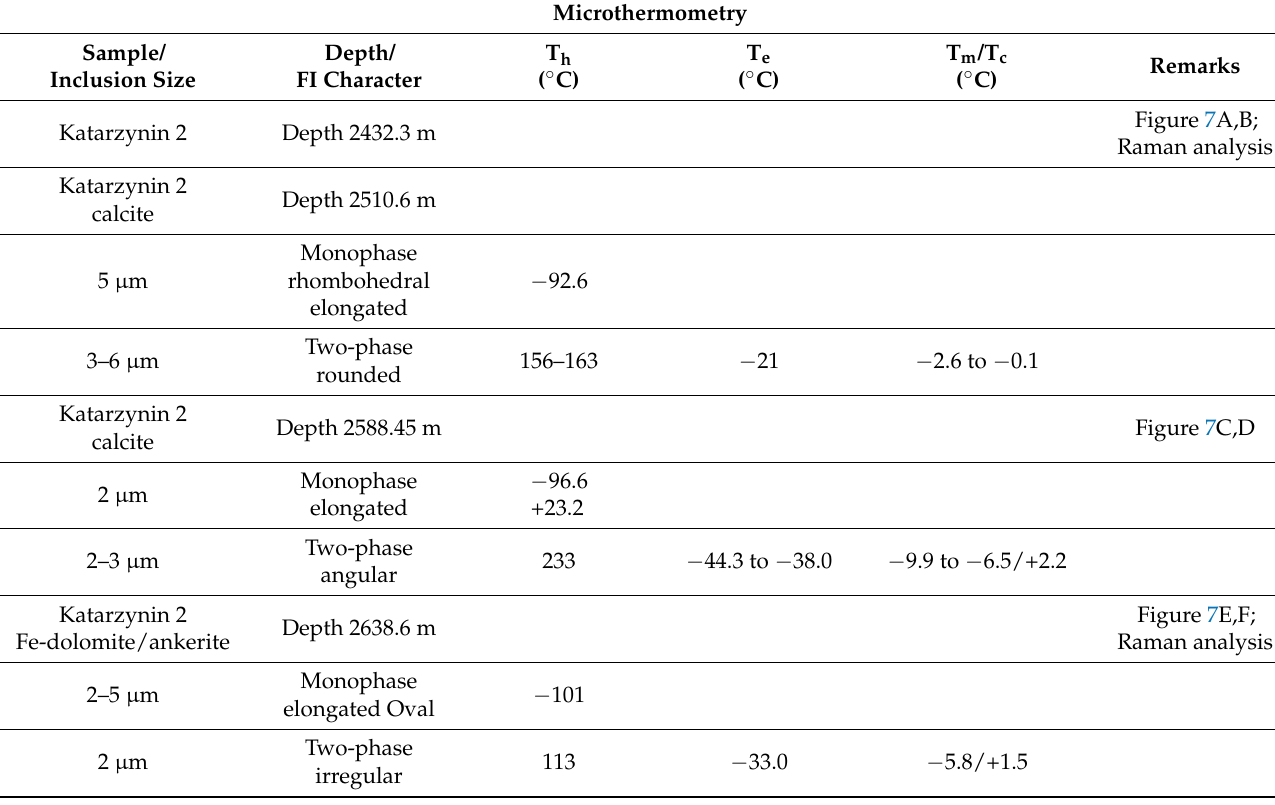
Table 5. Characteristics of fluid inclusions in the Katarzynin 2 borehole. Microthermometry